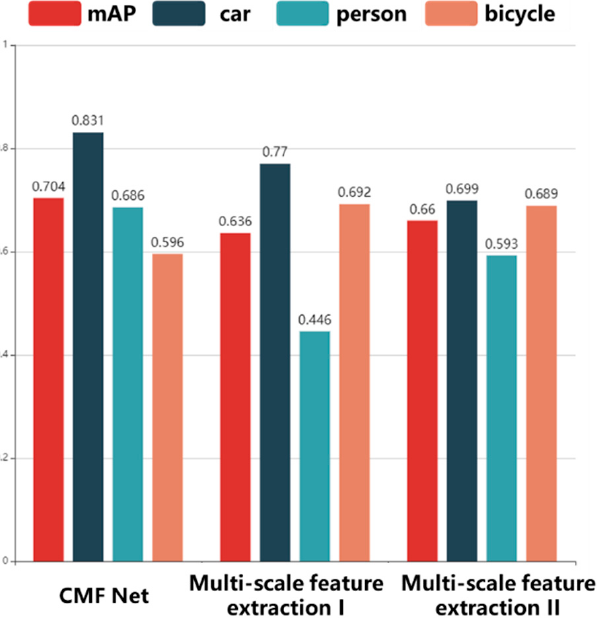
Figure 8. Performance comparison between CMF Net and two multiscale feature extraction mechanisms.